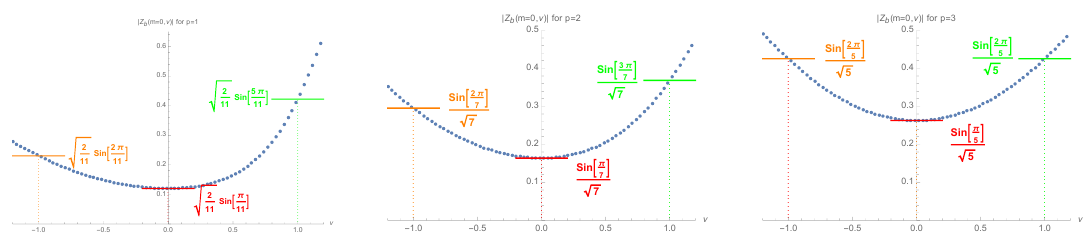
( m = 0 , ν ) | as a function on − 1 . 2 < ν < 1 . 2 for p = 1 , 2 , 3 . The minimums are b =1